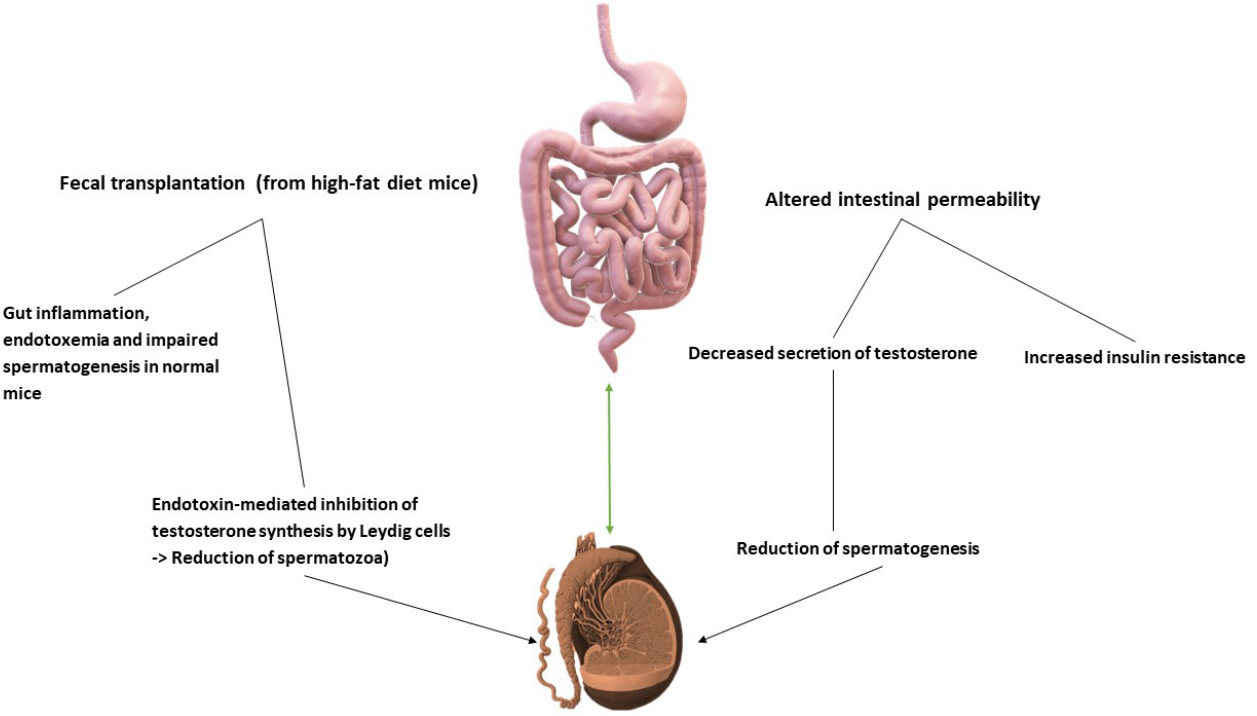
Figure 4. The gut–testis axis. The existence of the gut–testis axis is supported by different evidence. Fecal transplantation from high-fat diet mice to normal mice accounts for endotoxemia occurrence and altered spermatogenesis. In turn, endotoxemia abrogates synthesis of testosterone from Leydig cells, thus reducing the number of spermatozoa with increased release of pro-inflammatory cytokines. Insulin resistance as a result of an altered intestinal permeability leads to a reduced